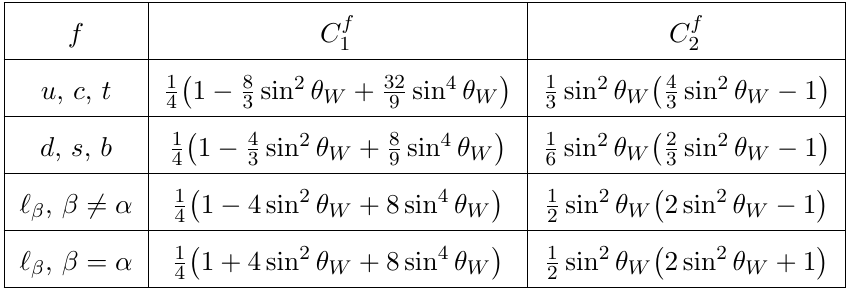
Table 3 . Coe(cid:14)cients C 1 and C 2 for the neutral current-mediated decay